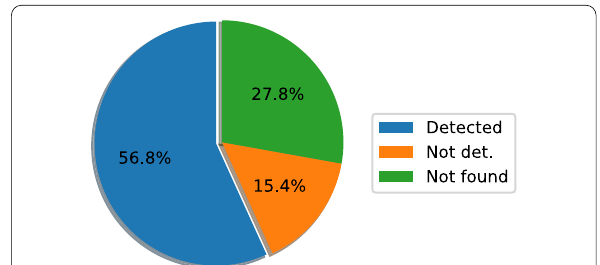
Fig. 10 The re-verification (using the VirusTotal analysis) for IOCs that are not able to be verified the campaign stages through Relationships . Note: Not found is a fraction of IOCs that are not found in VT, Not det. indicates that the IOCs are found in VT but none of the antivirus scanners mark it as malicious, and Detected represents the number of the IOCs that are found in VT and are labeled malicious by at least one antivirus